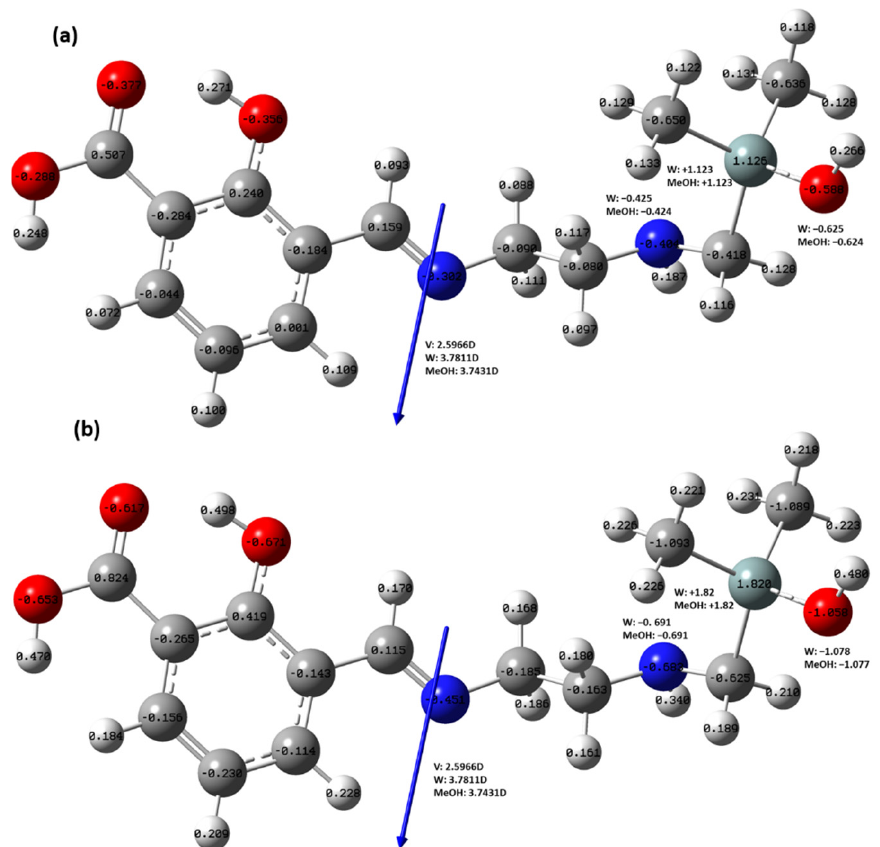
Figure 10. Partial charges for SB-silanol: ( a ) Mulliken, ( b ) NPA from NBO; implicit solvents: W—water, MeOH—methanol, V—vacuum.